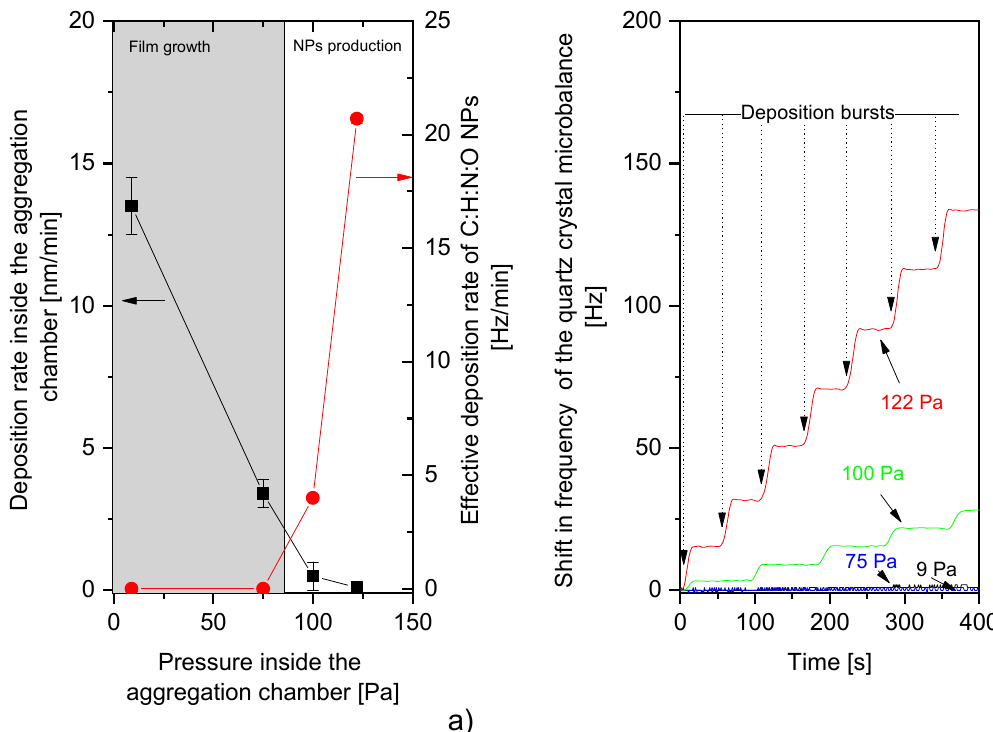
Figure 2. ( a ) Pressure dependences of the deposition rate of C:H:N:O film inside the aggregation chamber and e ff ective deposition rate of C:H:N:O NPs in the main deposition chamber. ( b ) Pressure dependences of frequency shift on quartz crystal microbalance (QCM) installed into the main deposition chamber. The change in the frequency of quartz crystal is directly proportional to the deposited mass. RF power 40 W.